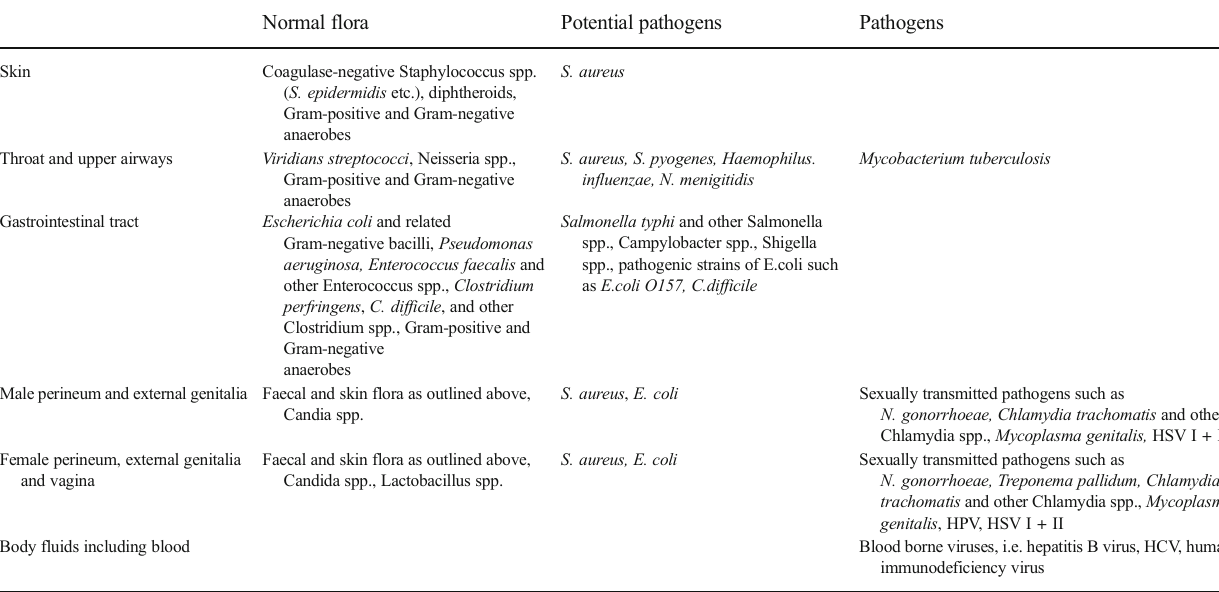
Body sites and their physiological flora and potential pathogens Normal